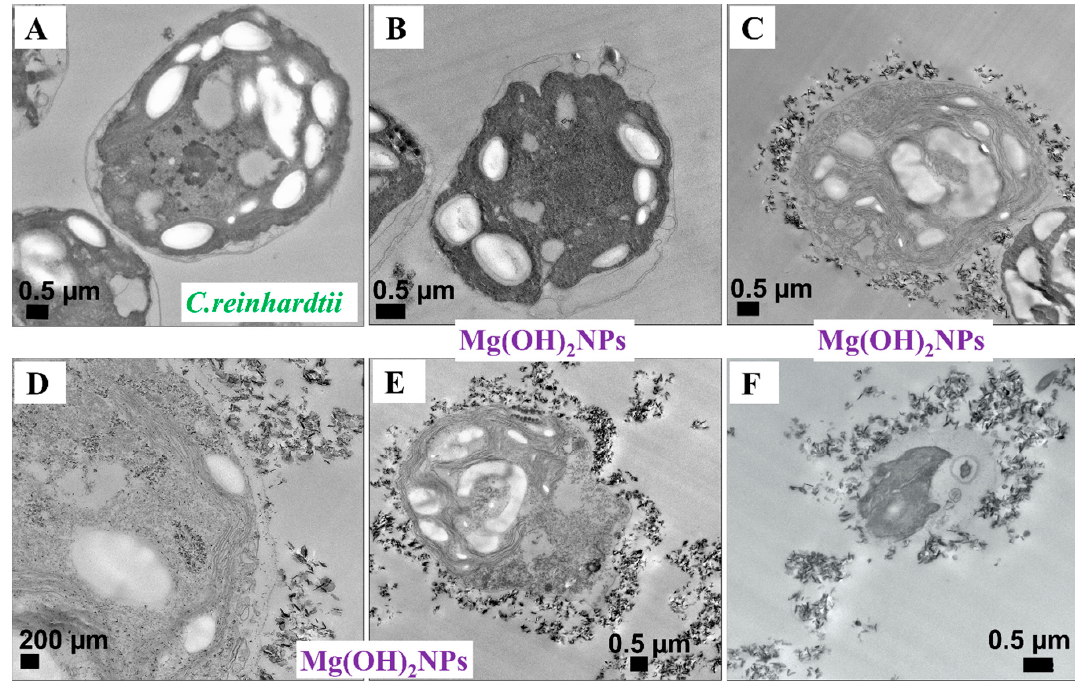
Figure 6. TEM images of C. reinhardtii after being exposed to 0, 250, 750, 1000 and 5000 µg mL − 1 Mg(OH) 2 NPs for six hours (fixed, embedded in resin and sectioned). ( A ) An untreated sample without Mg(OH) 2 NPs; ( B ) C. reinhardtii treated with 250 µg mL − 1 Mg(OH) 2 NPs; ( C ) and ( D ) C. reinhardtii incubated with 750 µg mL − 1 Mg(OH) 2 NPs at different magnifications. ( E ) and ( F ) C. reinhardtii treated with 1000 µg mL − 1 and 5000 µg mL − 1 Mg(OH) 2 NPs, respectively.